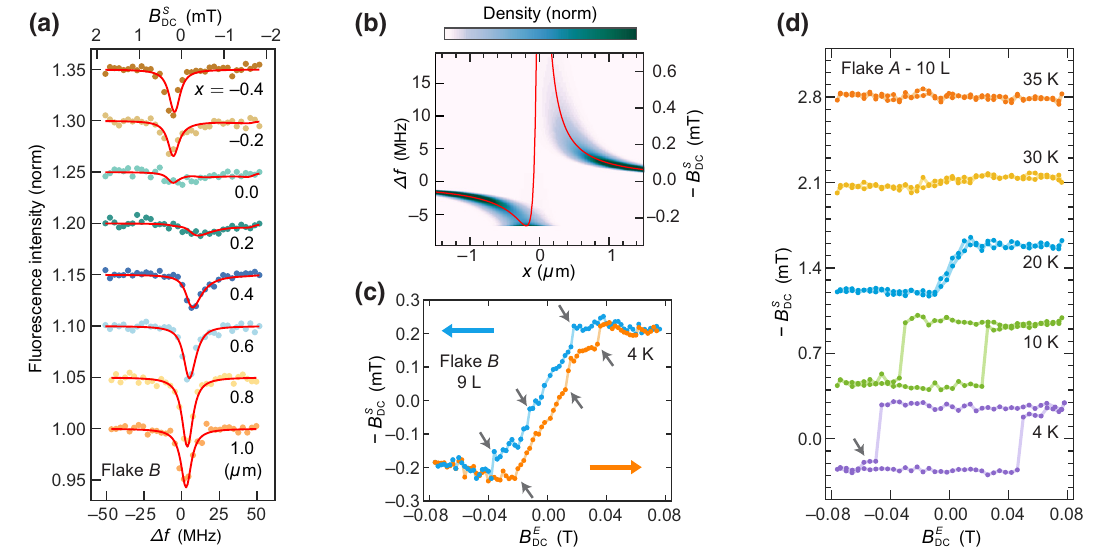
FIG. 2. dc magnetometry of ultrathin CrBr 3 . (a) Linecut of the ODMR spectra across the right edge of Flake B (nine layers) at = 76 mT and T = 4 K. Positive (negative) x denotes the exterior (interior) of the flake. Here (cid:7) f is the shift in frequency from the B E dc resonance of NV centers far from the flake ( x ≈ 4 μ m). The red lines are fits using a model that considers magnetic field gradients over the optical spot for an ensemble NV sample. (b) Illustration of the distribution of stray fields B S over the optical spot sensed by dc the NV ensemble. The stray field distribution (density plot) at position x corresponds to the stray field from an infinite magnetized edge (red line) weighted by a Gaussian distribution centered around x for the optical intensity. (c) Magnetic hysteresis curve for Flake , slowly reverses due to domain wall pinning. Discrete Barkhausen jumps are B. The magnetization M , which is proportional to − B S dc marked by the arrows. (d) Temperature-dependent hysteresis curves for Flake A (ten layers). Flake A displays rectangular hysteresis, indicating minimal pinning of domain walls once